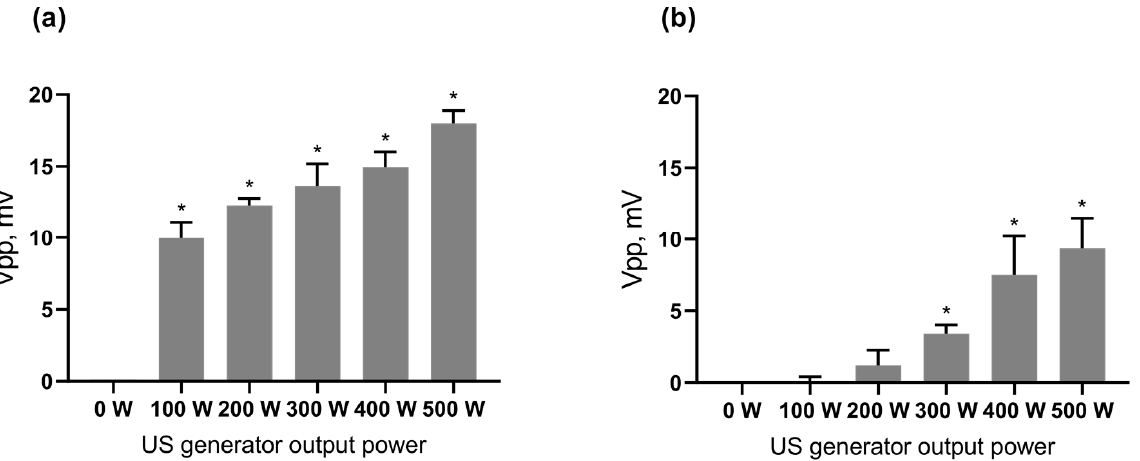
Figure 2. Sonoluminescence intensity: ( a )—directly in the US bath, ( b )—in the well of the plate, placed in the US bath; *— p ≤ 0.01 in comparison with 0 W output power.